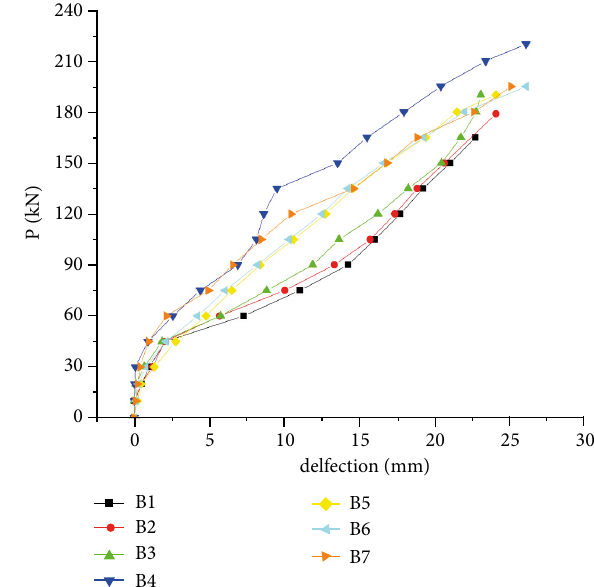
Figure 7: Influence of steel fiber on